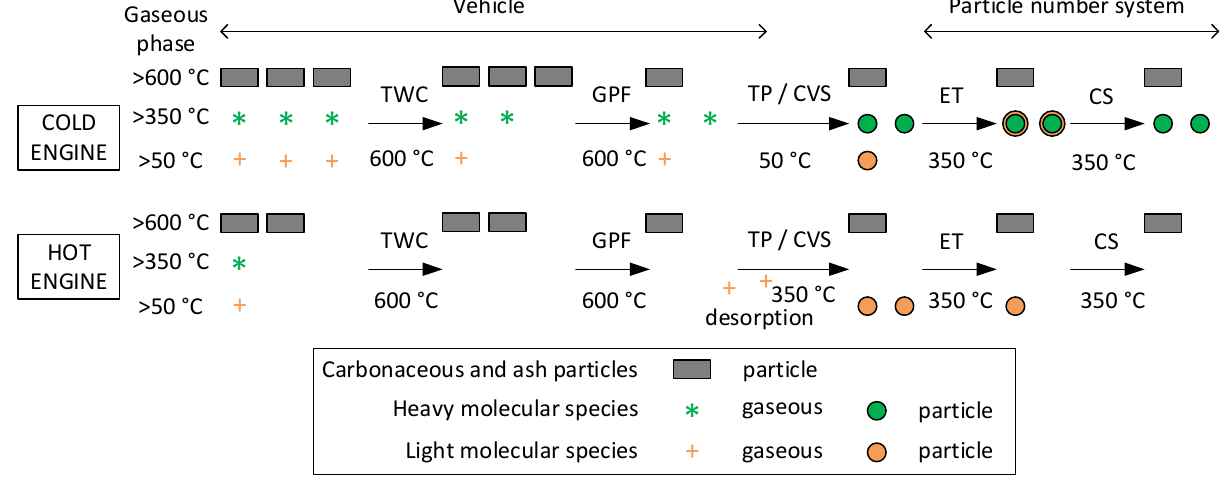
Figure 6. Schematic explanation of the results. CS = catalytic stripper; CVS = constant volume sampling (dilution tunnel); ET = evaporation tube; GPF = gasoline particulate filter; TP = tailpipe; TWC = three-way catalyst.